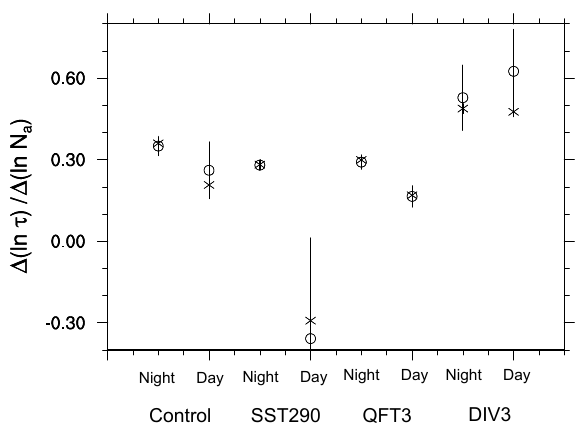
Fig. 13. Averaged ∆(ln τ ) / ∆(ln N a ) from the LES model (unfilled circle) and Eq. (3) (asterisk) for specific Fig. 13. Averaged 1( ln τ)/1( ln N a ) from the LES model (unfilled sensitivitysimulationsundernighttime(4–7h)anddaytime(12–15h),asshowninlasttwocolumnsofTable4. circle) and Eq. (3) (asterisk) for specific sensitivity simulations un- The error bar (standard deviation) is computed from LES experiments. der nighttime (4–7h) and daytime (12–15h), as shown in last two columns of Table 4. The error bar (standard deviation) is computed from LES